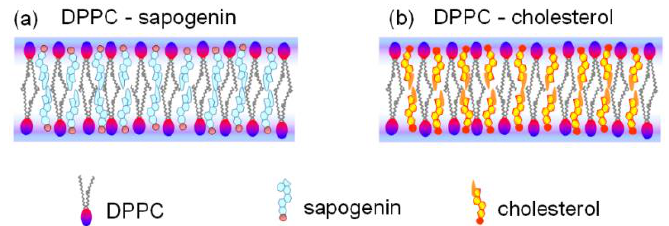
Figure 7. Proposed models of the lipid bilayer organization of DPPC-sapogenin ( a ) and DPPC-cholesterol ( b ) complexes.